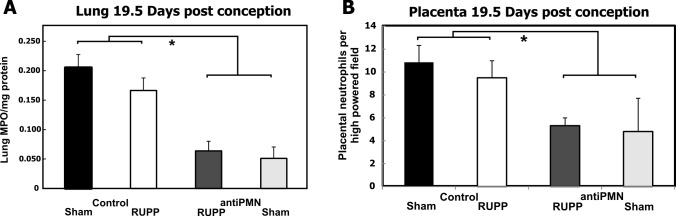
Treatment with antiPMN antibody reduces lung myeloperoxidase (MPO) activity and reduces neutrophils in placenta.Animals were treated with normal rabbit serum (Control) or antiPMN antibody from 13.5–18.5 dpc. *p<0.05 for antiPMN effect by analysis of variance. A). Lung MPO was used as an indicator of the number of neutrophils in the lung. AntiPMN treatment significantly reduced MPO compared to normal rabbit serum treatment. Values represent mean ± SE of Units of lung MPO activity per mg protein of lung homogenate in lungs collected from 5–14 animals on 19.5 dpc. B). AntiPMN treatment significantly reduced the number of neutrophils in placenta compared to normal rabbit serum treatment. Values represent mean ± SE of placental neutrophils per high-powered field in placenta collected from 3–6 animals on 19.5 dpc.